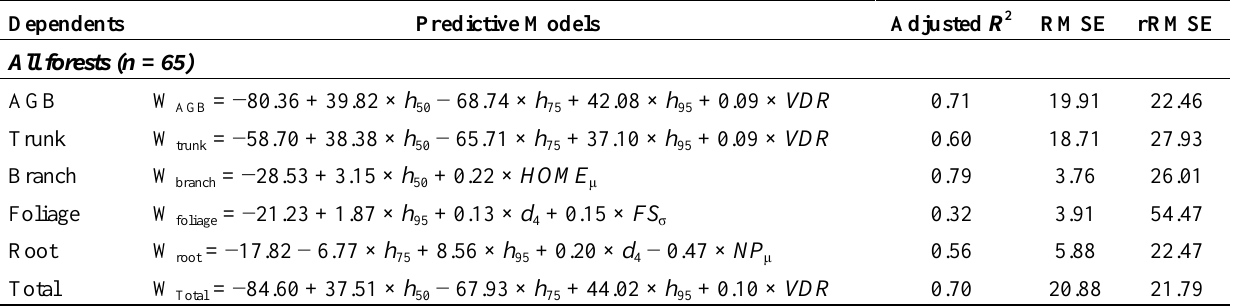
Table A3. Combo models and accuracy assessment results (using both discrete and full-waveform metrics as a pool of candidate